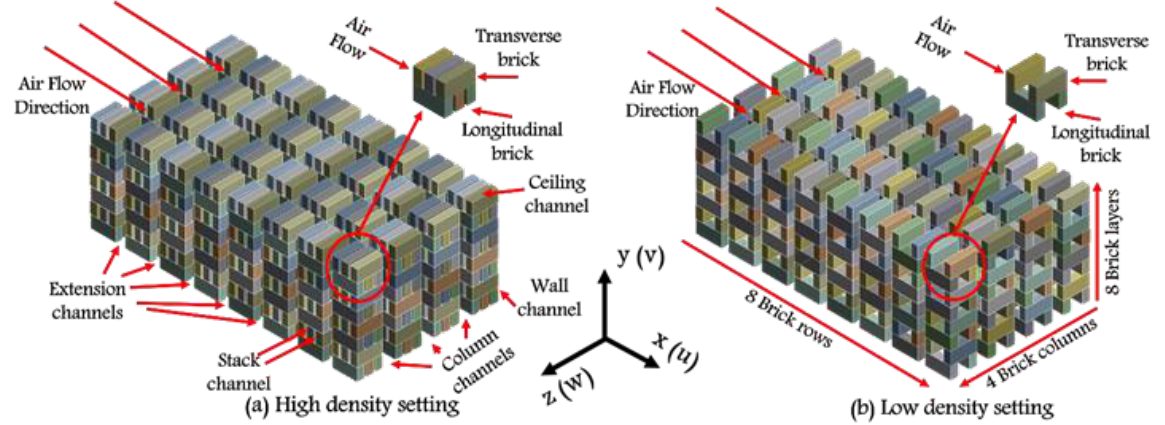
Figure 1. The two tested lattice settings showing brick orientations and brick faces: ( a ) high-density setting; ( b ) low-density setting [51].